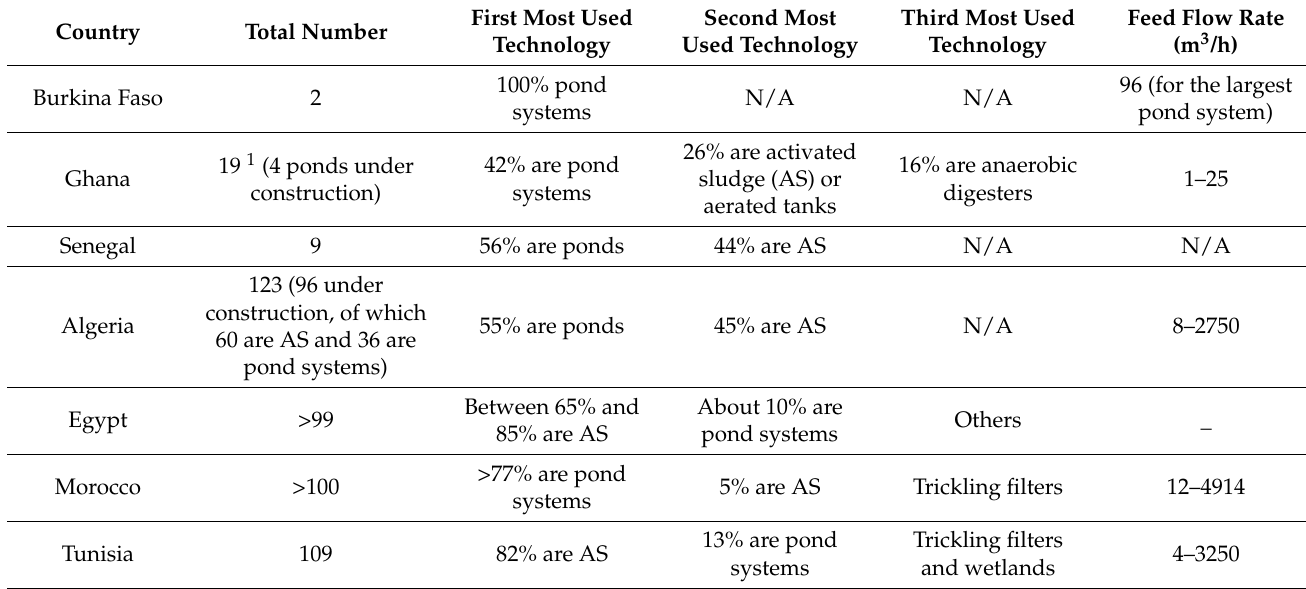
Table 1. Overview of the insufficient wastewater treatment plants (WWTPs) in operation at the seven selected countries (Algeria, Burkina Faso, Egypt, Ghana, Morocco, Senegal, and Tunisia)